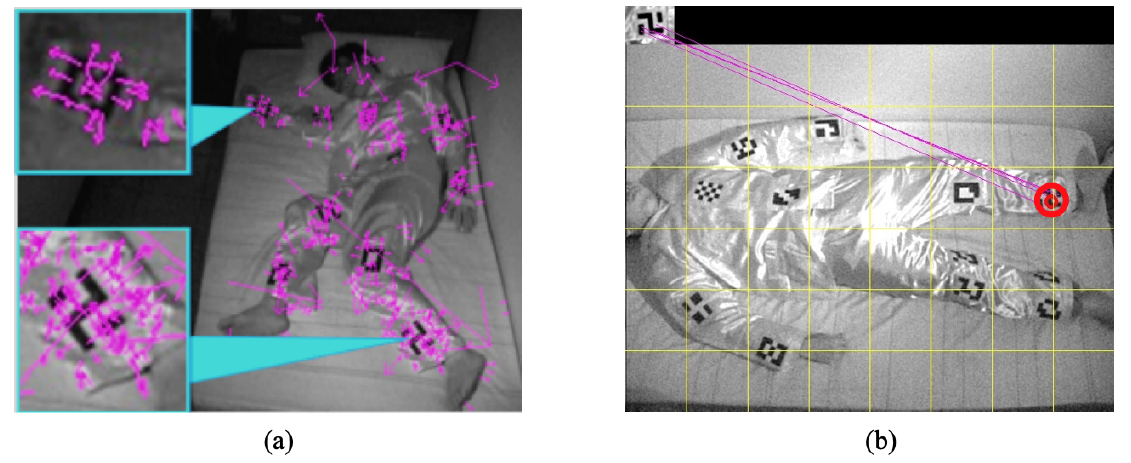
Figure 3. Keypoint detection and joint detection. ( a ) Image descriptor of an original lateral-pose image overlaid with keypoints of length and orientation information. Each arrow represents one detected keypoint. ( b ) A joint detection example for left ankle. It is detected by matching a specific joint marker representing the left ankle with a visual marker in the sleep